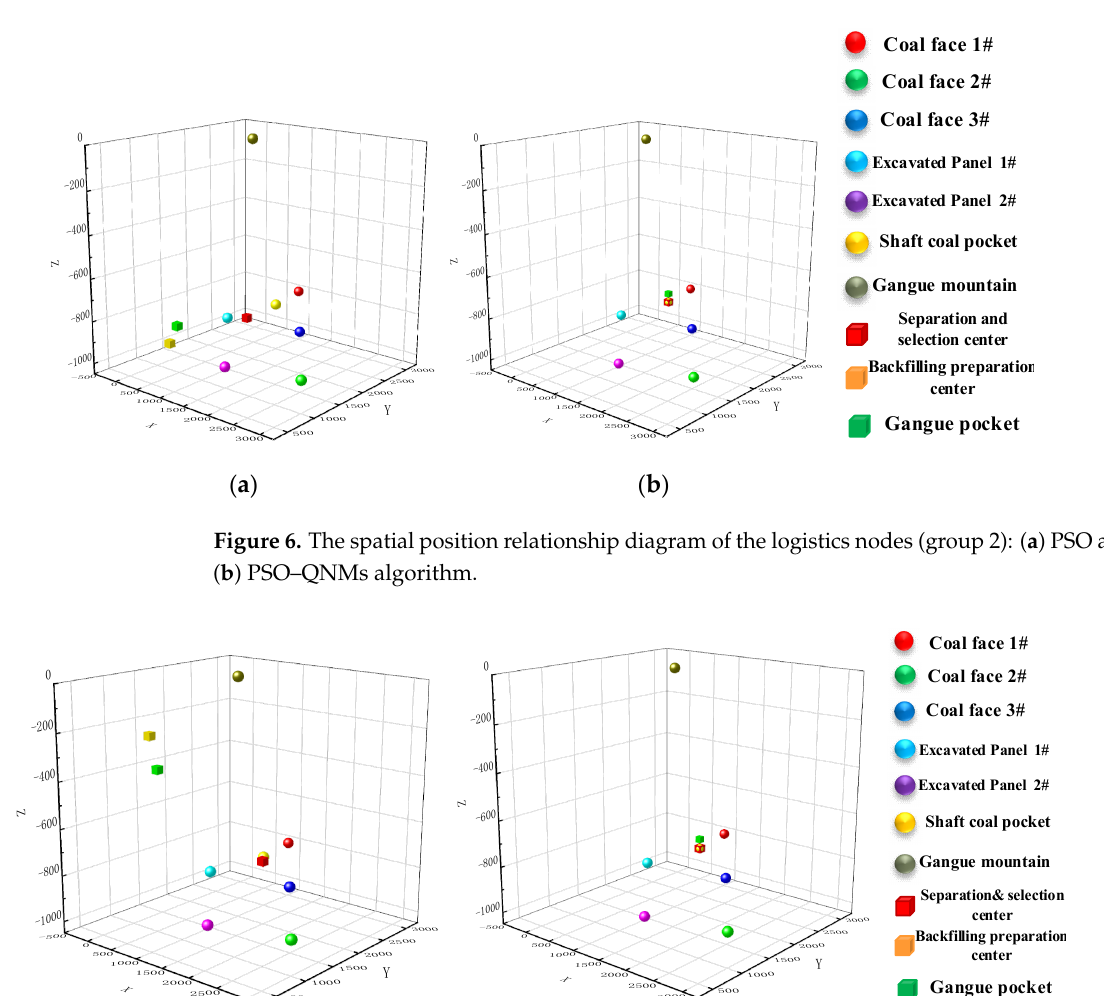
Figure 5. The spatial position relationship diagram of the logistics nodes (group 1): ( a ) PSO algorithm, ( b ) PSO–QNMs algorithm.